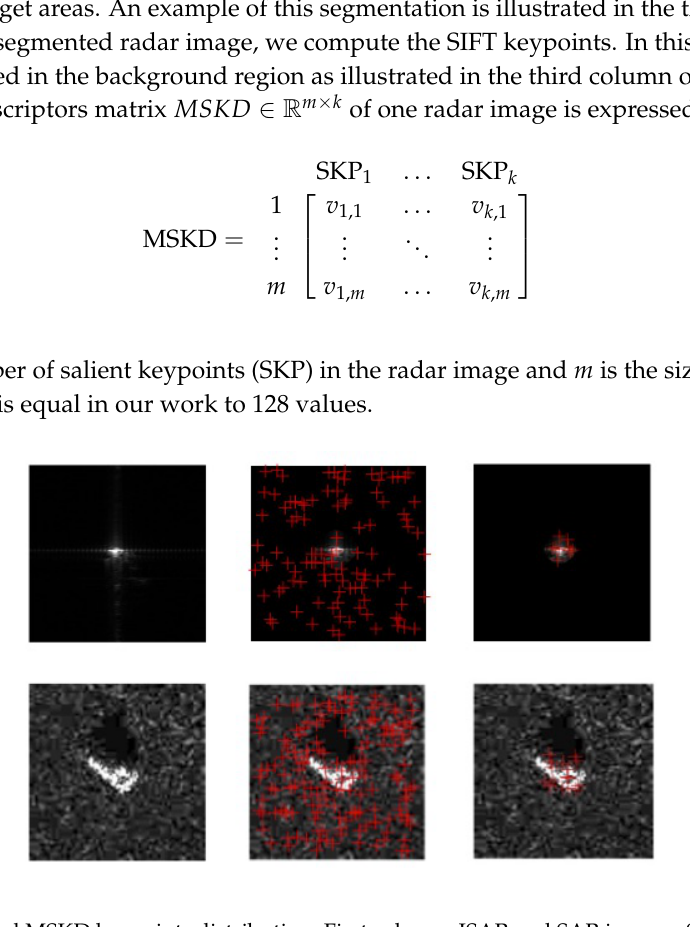
Figure 2. SIFT and MSKD keypoints distribution. First column: ISAR and SAR images. Second column: SIFT keypoints distribution. Third column: MSKD keypoints